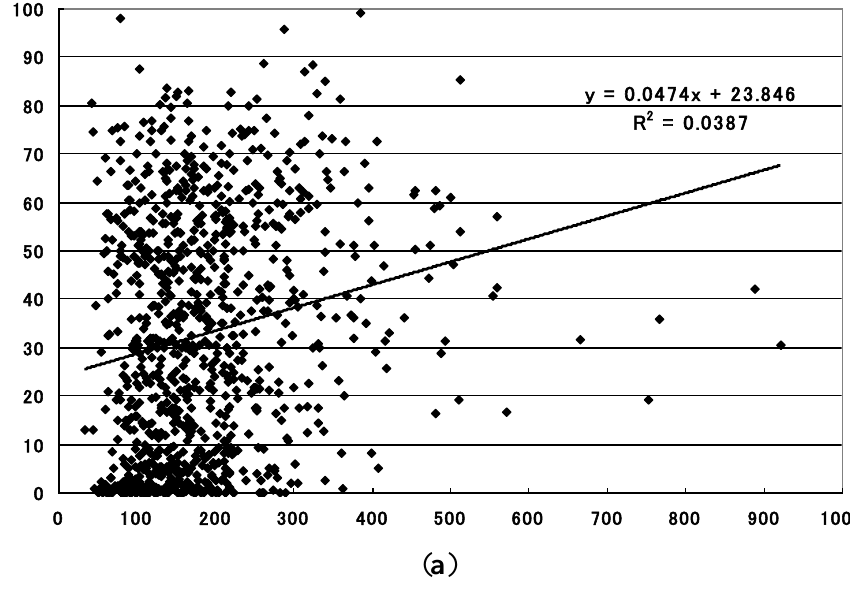
Figure 3. Relationship between summertime precipitation and sero-conversion rate to JE virus in sentinel pigs in the whole of Japan. ( a ) Statistically significant positive relationship with the mean sero-conversion rate ( p = 1.156 × 10 −9 ). X-axis: precipitation during the period (mm), Y-axis: sero-conversion rate to JE virus (%); ( b ) Statistically significant positive relationship with the maximum sero-conversion rate ( p = 1.344 × 10 −9 ). X-axis: precipitation during the period (mm), Y-axis: sero-conversion rate to JE virus (%).